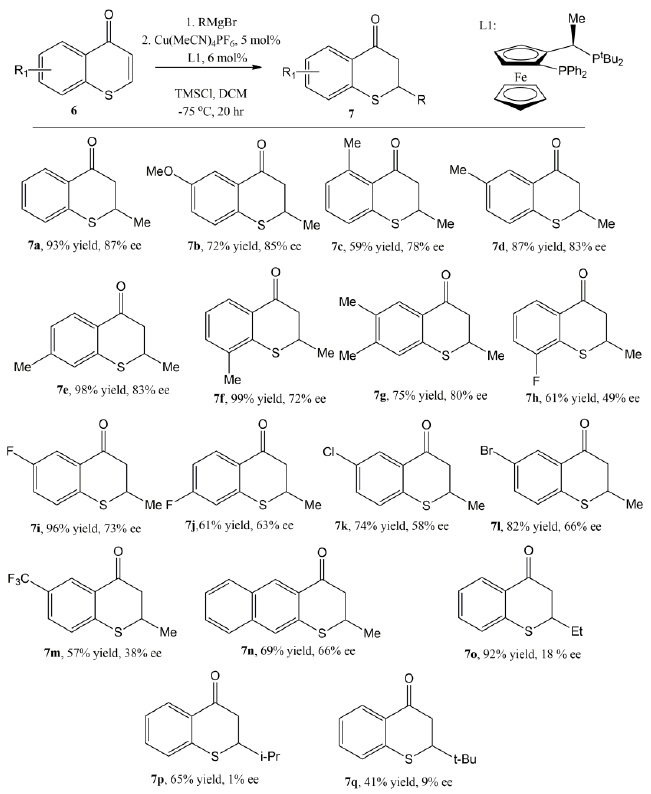
Figure 10. The Scope of Enantioselective Cu-catalyzed conjugate addition to